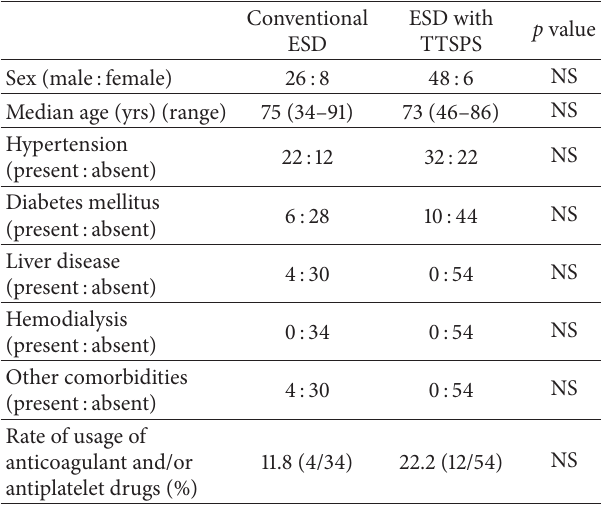
Table 1: Patients’